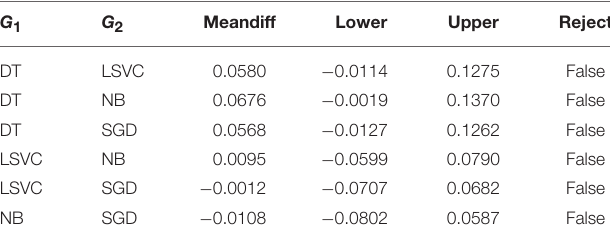
TABLE 9 | The influence of classifier through multiple comparison of means - Tukey HSD, FWER=0.05. G